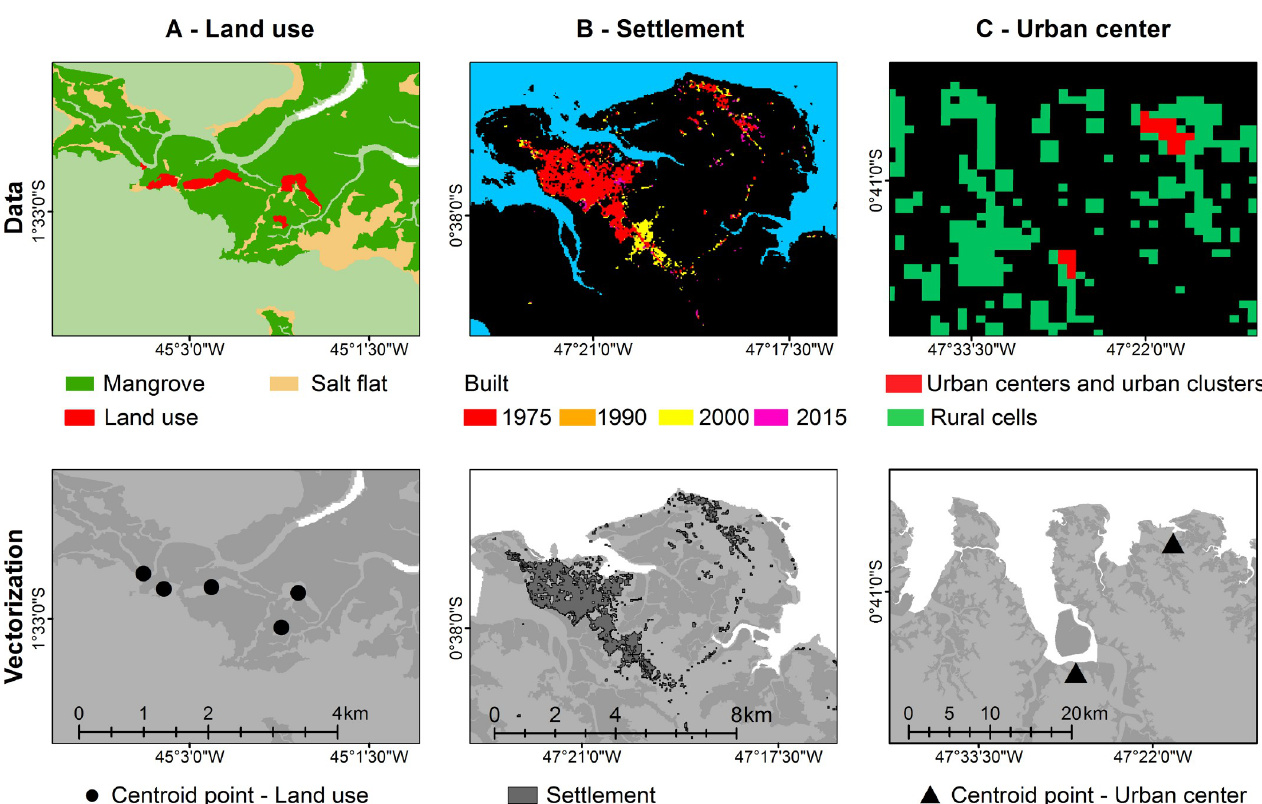
Fig 2. Data vectorization of the Brazilian Amazon coast. A) each record of land use is represented by a point at the centroid of a polygon of the area of mangrove affected. B) settlements recorded in 1975, 1990, 2000, and 2015 are represented by dark gray polygons. C) urban centers are represented by black triangles at the centroid of the